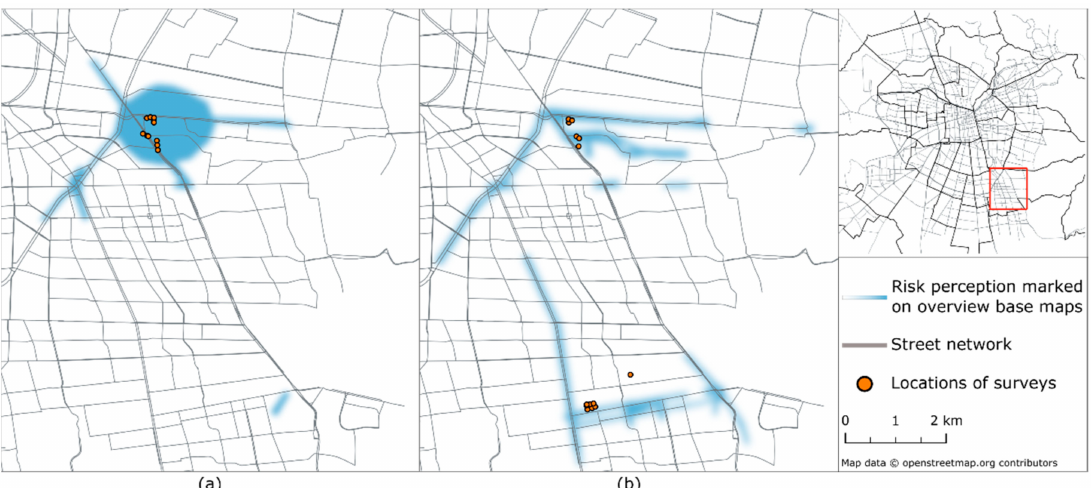
Figure 6. Comparison of the risk perception of 12 pedestrians ( a ) and 18 residents ( b ) based on the overview maps. The orange points indicate the position of the people during the survey.